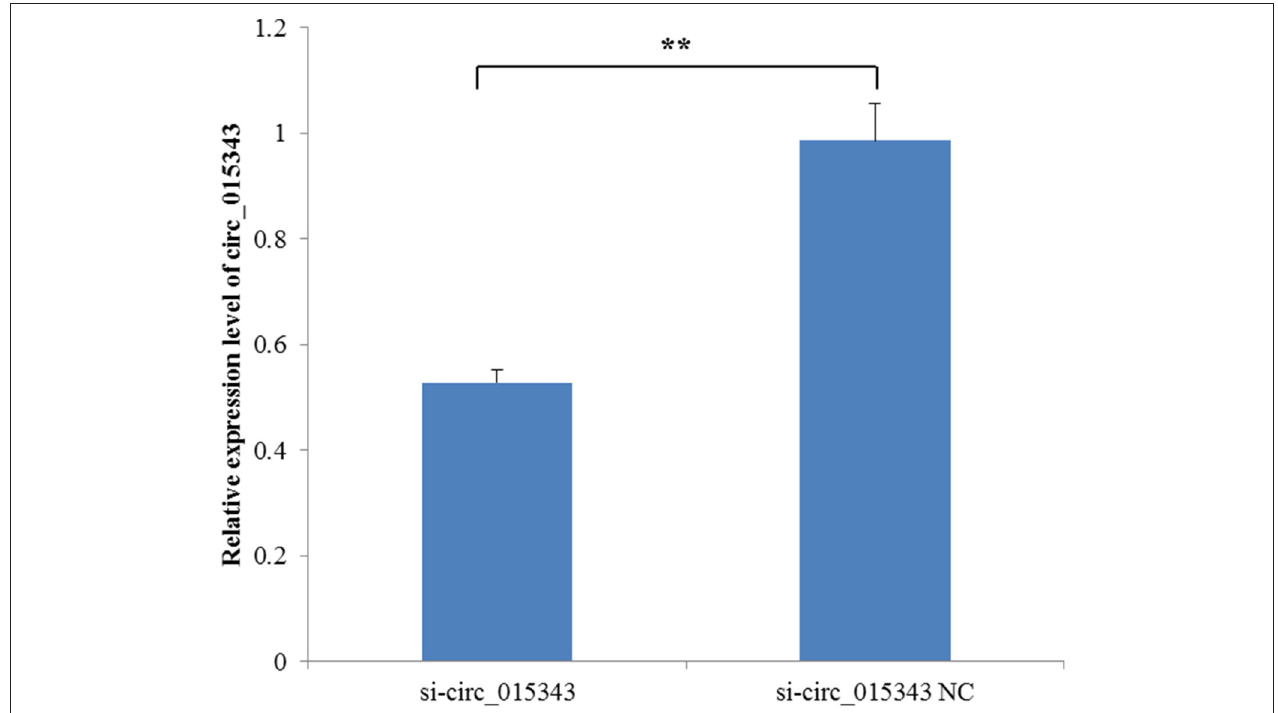
FIGURE 5 | The expression level of circ_015343 when si-circ_015343 and si-circ_015343 NC were transfected into ovine mammary gland epithelial cells. ** p < 0.01.